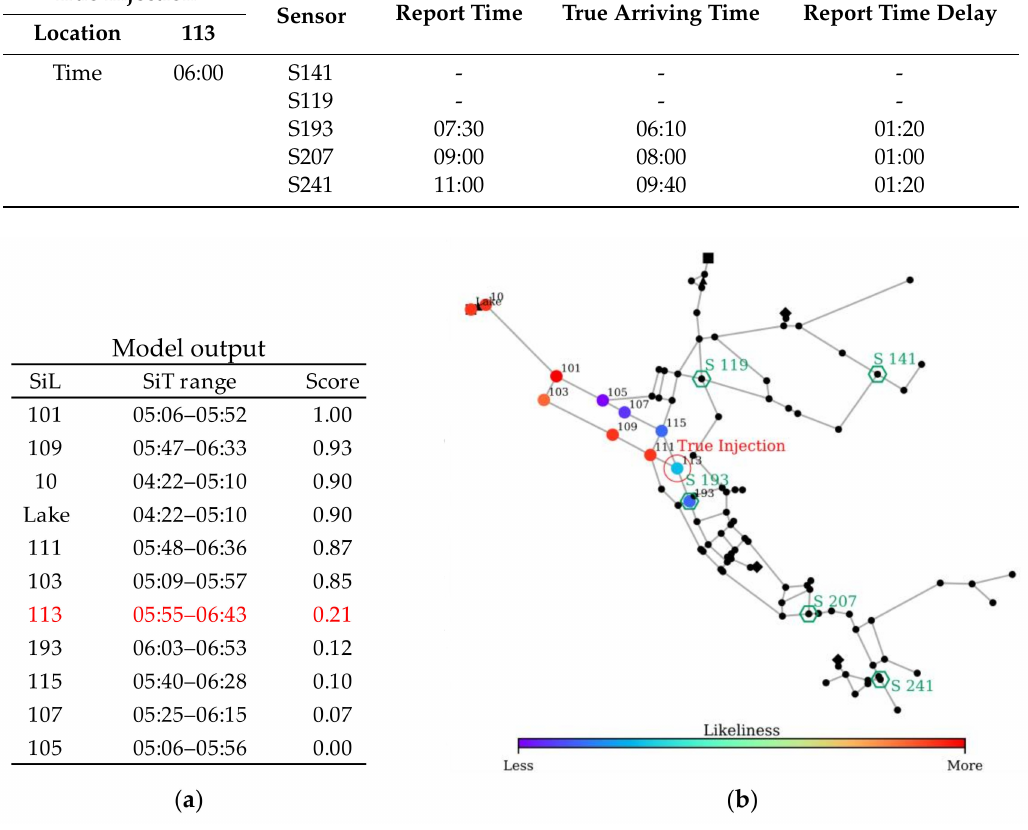
Figure 13. CPSITE simulation results of scenario 3: ( a ) Model output and ( b ) SiL